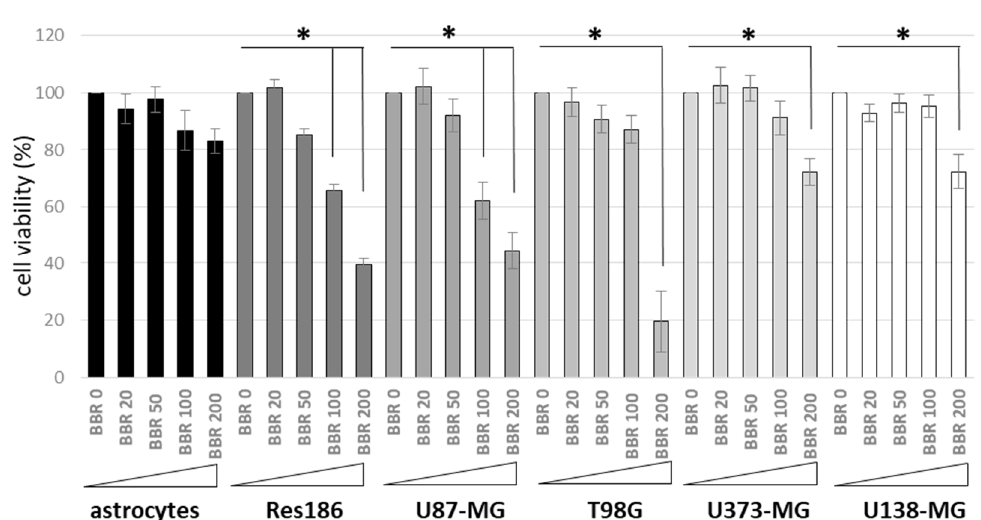
Figure 1. Cell Viability Assays after BBR administration. Low- (i.e., Res186) and high-grade (U87-MG, T98G, U373-MG, and U138-MG) astrocytoma cells lines and normal rat primary astrocytes were treated with different concentrations of BBR (0, 20, 50, 100, 200 µ g/mL for 4 h). Colorimetric MTS analysis was carried out after 24 h p.t. All experiments were performed in triplicates with independent assays. Asterisks indicated statistical significance compared to untreated cells ( p < 0.05, Anova One-way).